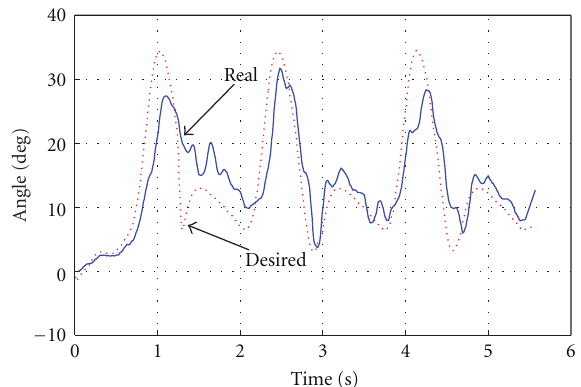
Figure 15: Real and desired knee joint angle of artificial leg during swing.